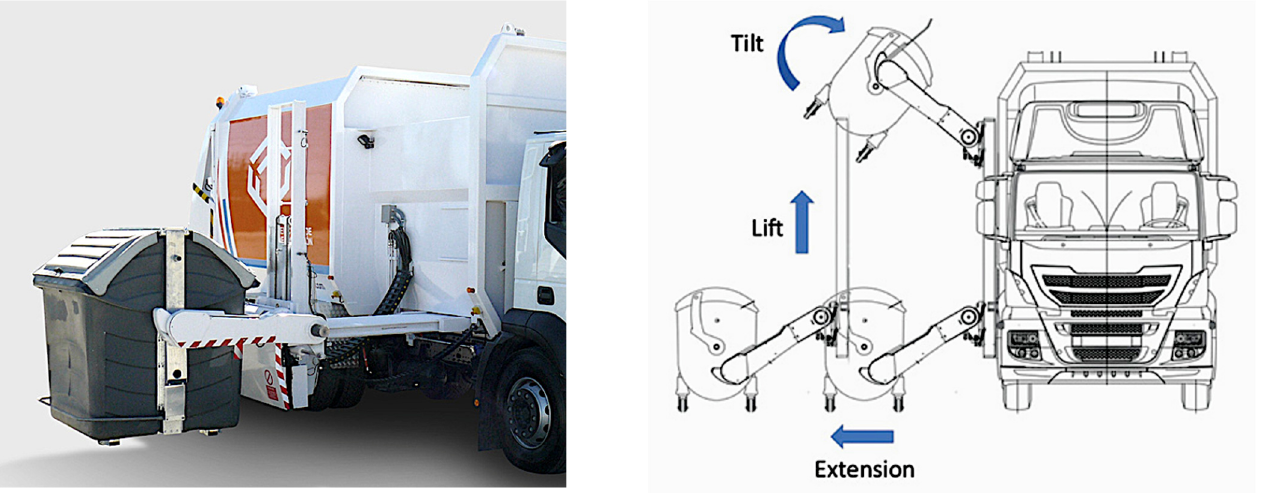
Figure 1. Load for the different actuators.